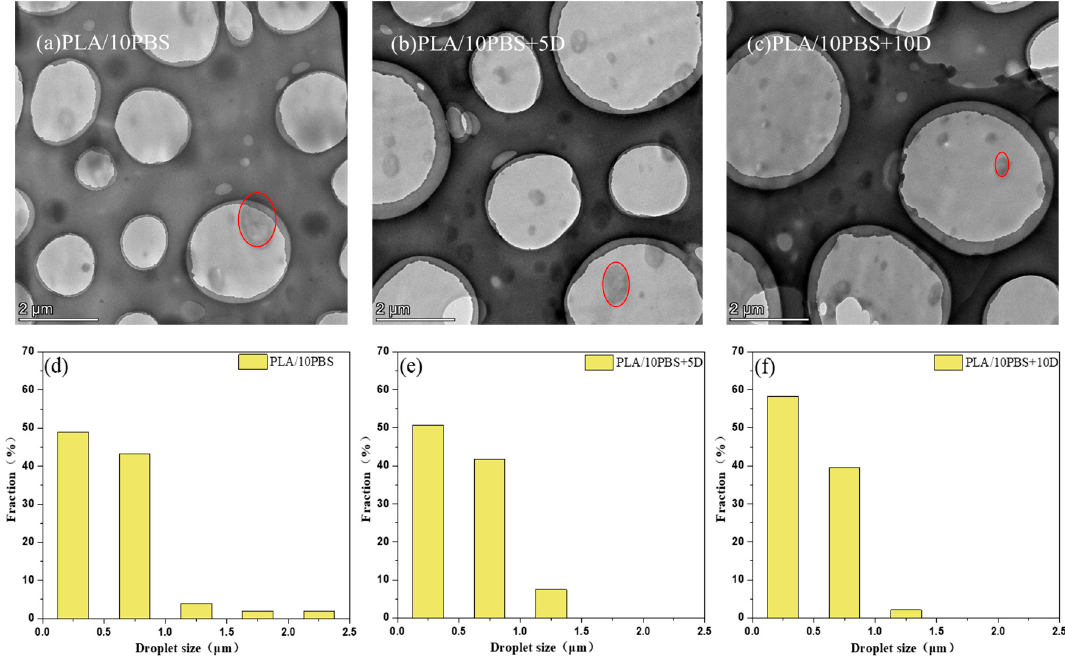
Figure 3. Transmission electron microscope (TEM) images for PLA / PBS blending with and without PDLA with scale bar in 2 µ m ( a ) PLA / 10PBS; ( b )PLA / 10PBS + 5D; ( c )PLA / 10PBS + 10D; ( d ) droplet size distribution of PLA / 10PBS; ( e ) droplet size distribution of PLA / 10PBS + 5D; ( f ) droplet size distribution of PLA / 10PBS + 10D. (The red circles represent PBS domains.)